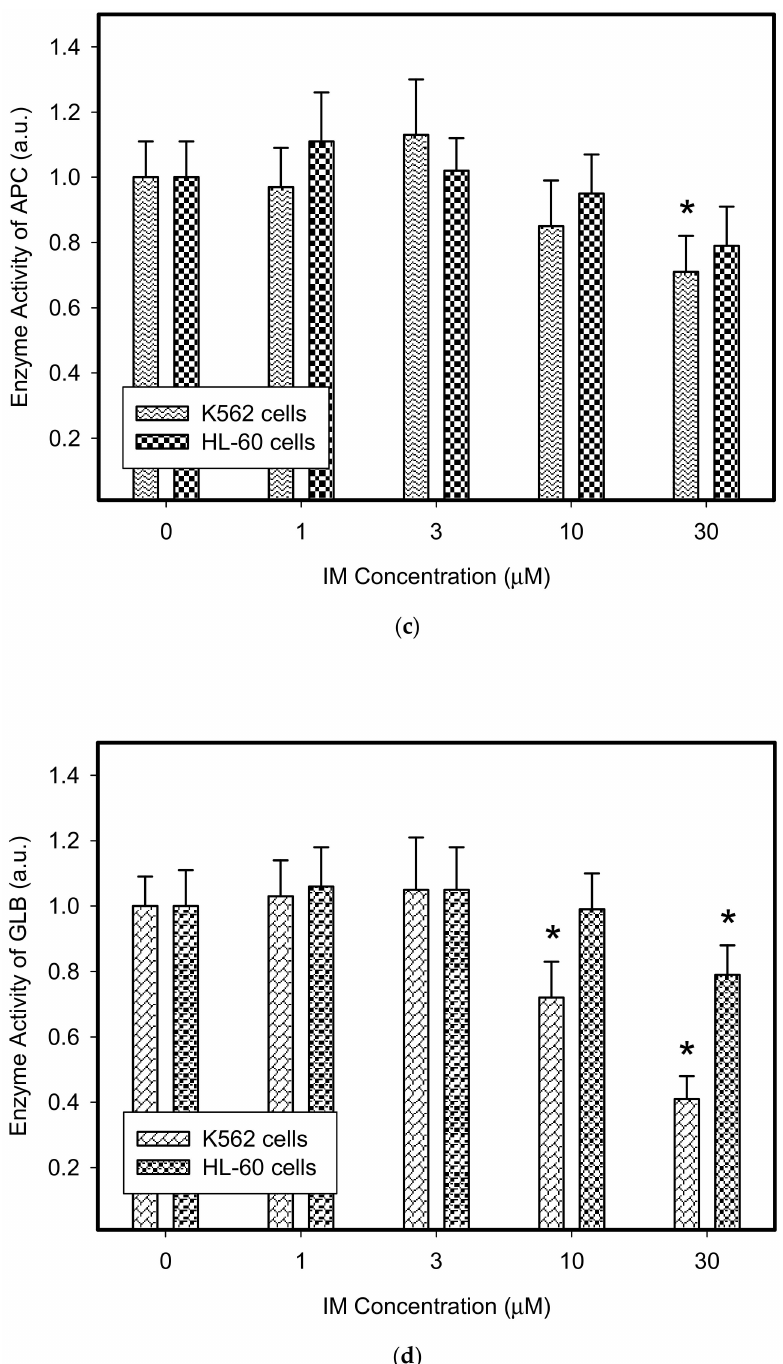
Figure 4. E ff ect of TKIs on activity of lysosomal hydrolases in cancer cells. Cells were cultured for 6 h in the presence of IM or GF as indicated and then enzymatic analysis of lysosomal hydrolases was done. Cells cultured in medium without TKIs were taken as a control. ( a ) Enzyme activity of lysosomal ACP in GF treated cells. ( b ) Enzyme activity of lysosomal GLB in GF treated cells. ( c ) Enzyme activity of lysosomal ACP in IM treated cells. ( d ) Enzyme activity of lysosomal GLB in IM treated cells. The columns represent the means of four independent experiments with standard deviations. * denotes significant change in the activity of lysosomal APC (or GLB) ( p < 0.05) between TKI treated and control